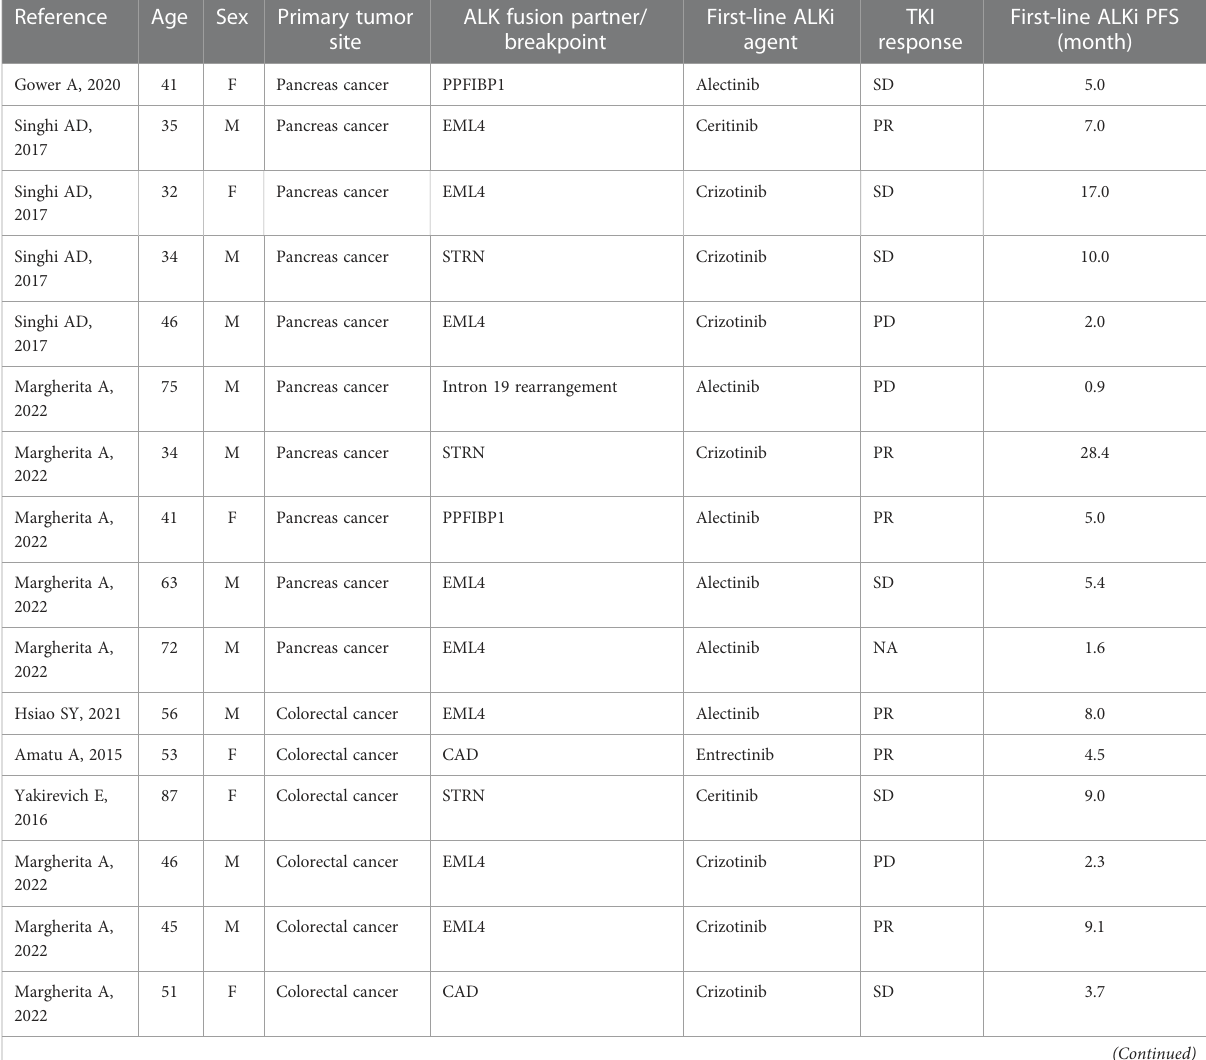
TABLE 1 Review of ALK inhibitors for patients with gastrointestinal cancers.